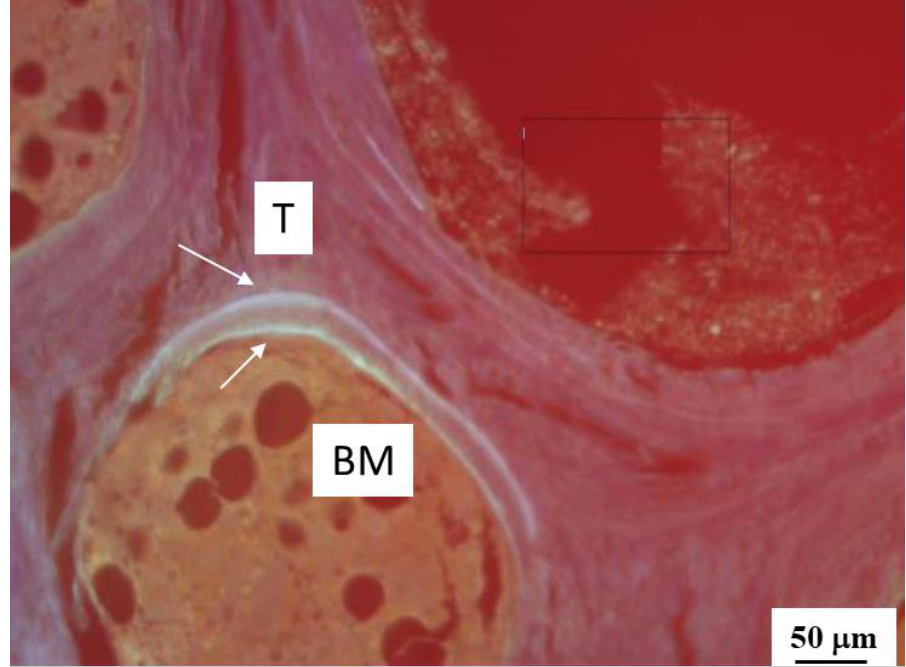
Figure 1. Representative image of OTC fluorescence double lines (arrows) at the interface between a bone trabecula (T) and the bone marrow (BM) close to the injection channel for the long-term, high-dose BMP-2 group.